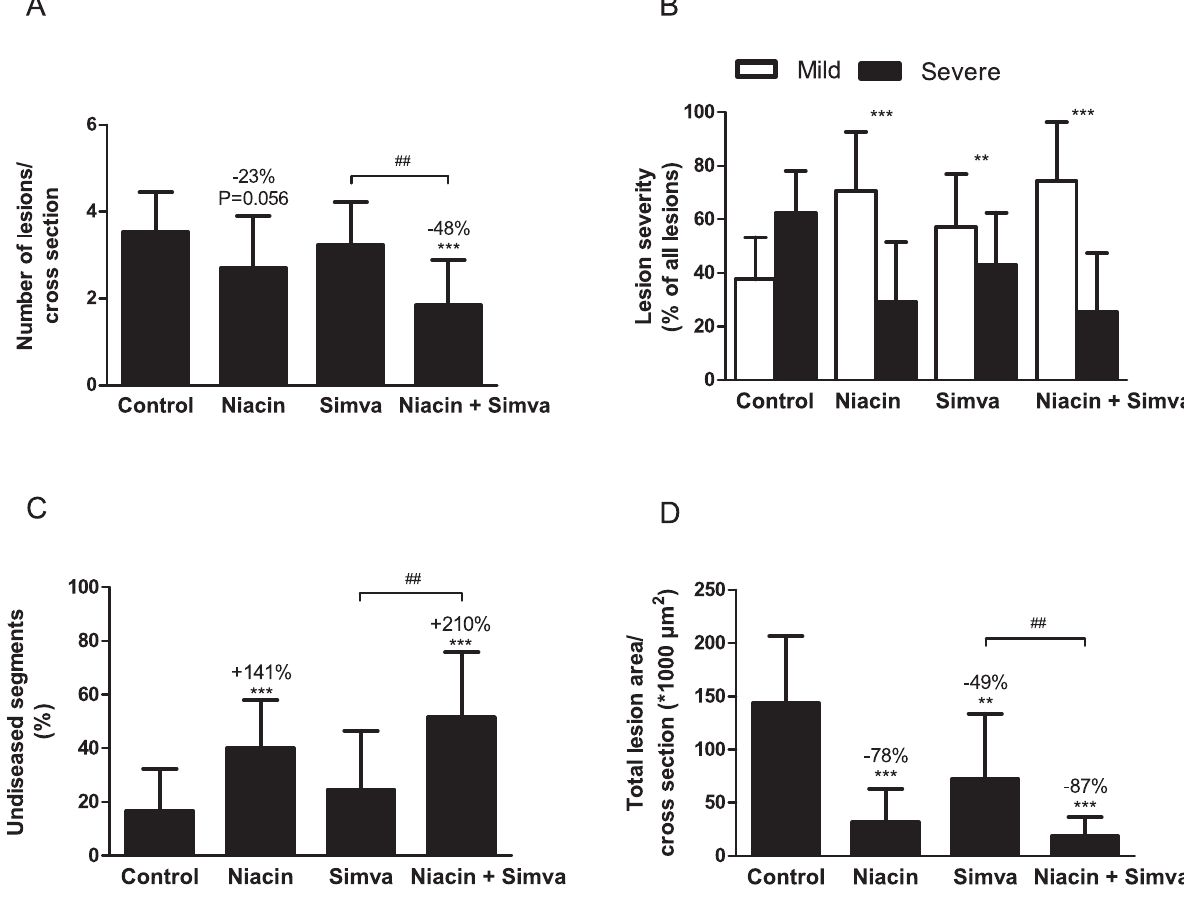
Figure 4. Effect of niacin, simvastatin and their combination on atherosclerosis development in aortic root area. After 18 weeks of treatment, number of lesions (A), lesion severity (B), percentage undiseased segments (C) and total lesion area (D) were determined per cross section. Lesion severity was classified as mild (type I–III) and severe (type IV–V) lesions. (Simva, simvastatin; values are means 6 SD; n=15 per group; **P , 0.01 and ***P , 0.001 as compared to control; ## P , 0.01 as compared to niacin +